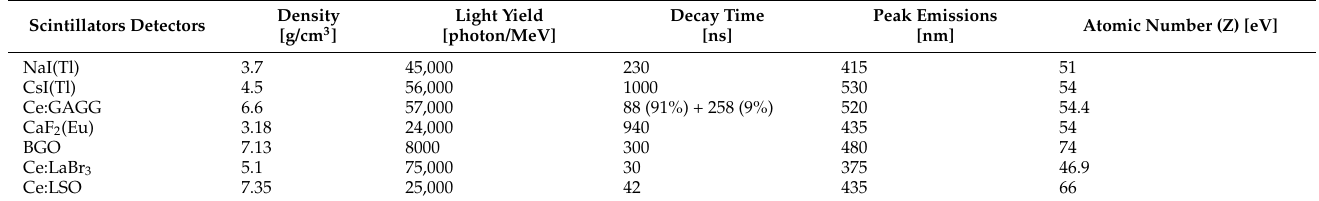
Table 3. Properties of some scintillator detectors used in Compton cameras.